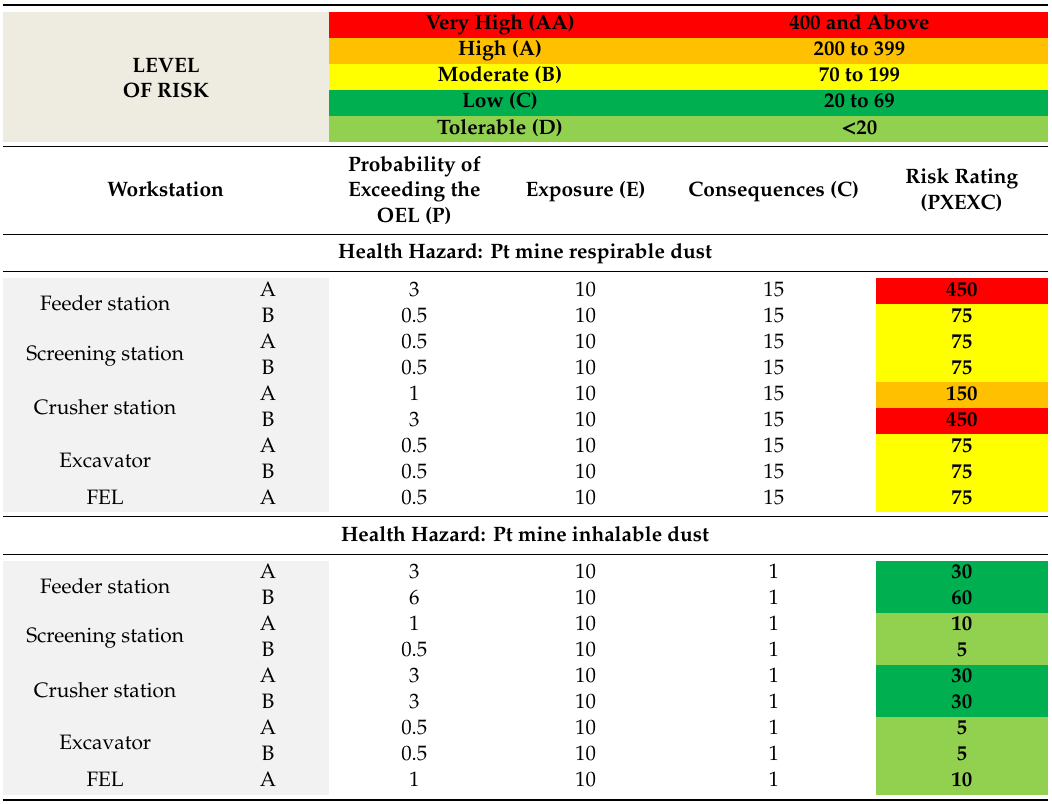
Table 6. Workstation’s risk rating and classification (Table